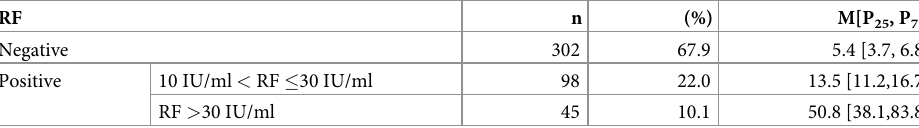
RF, rheumatoid factor. Variables were described as No. (%), median and interquartile range.